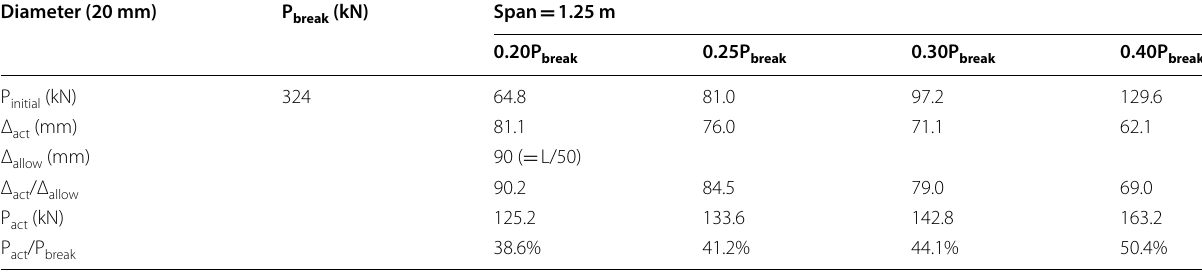
Table 5 W 1.25 m structural analysis =